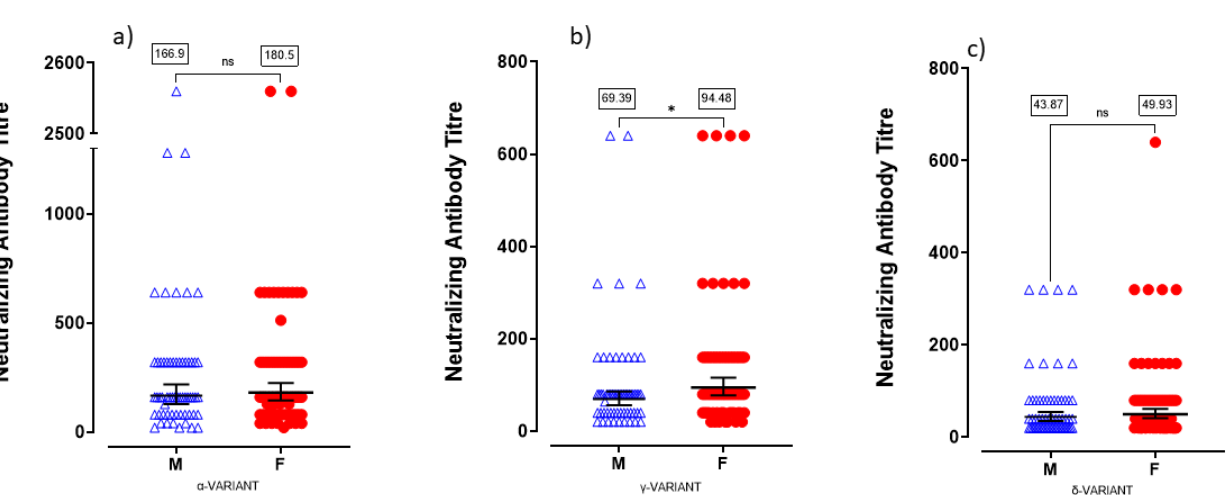
Figure 2. Gender effect on neutralizing antibody titre against variants of concern: ( a ) neutralizing antibody titre against Alpha variant in male and female subjects, ns = not significant; ( b ) neutralizing antibody titre against Gamma variant in male and female subjects, * p < 0.05; ( c ) neutralizing antibody titre against Delta variant in male and female subjects, ns = not significant.